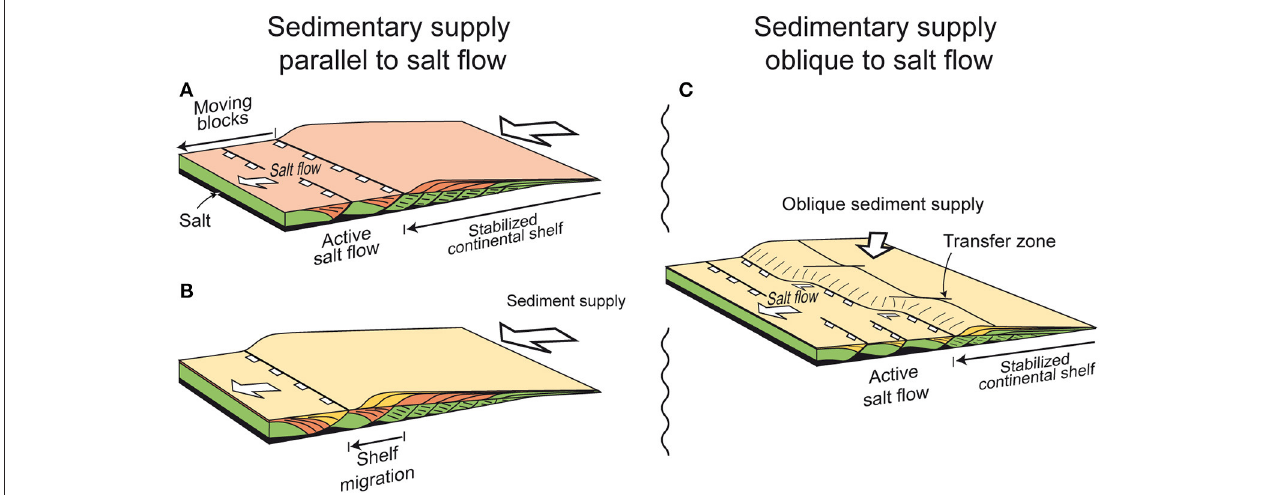
FIGURE 1 | Conceptual models for the development of a continental shelf at a passive margin involving active salt tectonics [Modified after (Fort and Brun, 2012)]: (A) and (B) show two successive stages of shelf break migration at a passive margin where sediment supply (Thick arrows) is parallel to salt flow (Thin arrows). Green, orange and yellow: successive depositional episodes. Normal faults trend parallel to the direction of salt flow. The position of shelf break for each episode is controlled by an active normal fault. Each new depositional episode seals the faults that were active during a previous depositional episode on the landward side of the shelf break. Below the stabilized continental shelf salt stopped flowing. Sediments deposited on the seaward side of the shelf break contribute to the growth of fault blocks that displace seaward on top of the flowing salt. (C) Tri-dimensional structure of a passive margin where sediment supply is oblique to salt flow. The shelf break is, like in (A) and (B) , controlled by normal faulting but it is offset by transfer zones trending parallel to the salt flow.